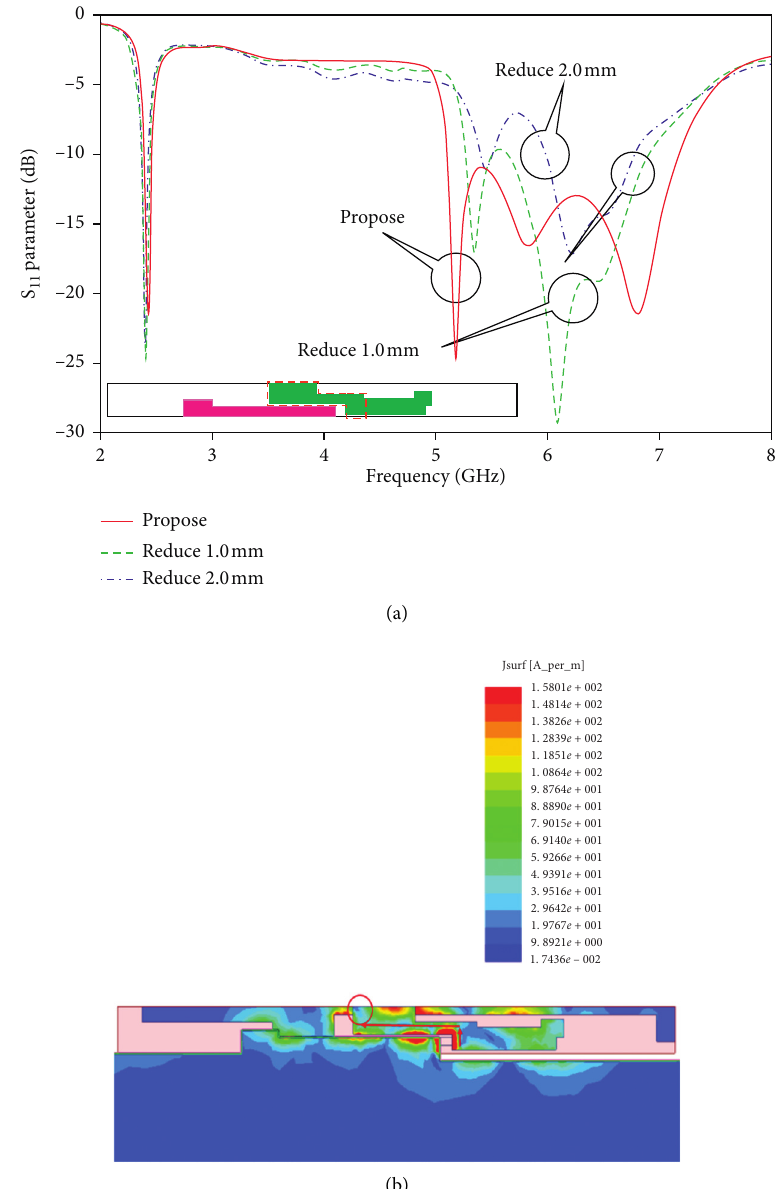
Figure 7: (a) Simulated S 11 values with different lengths of direct-fed left arm of antenna. (b) 5.16GHz current distribution of